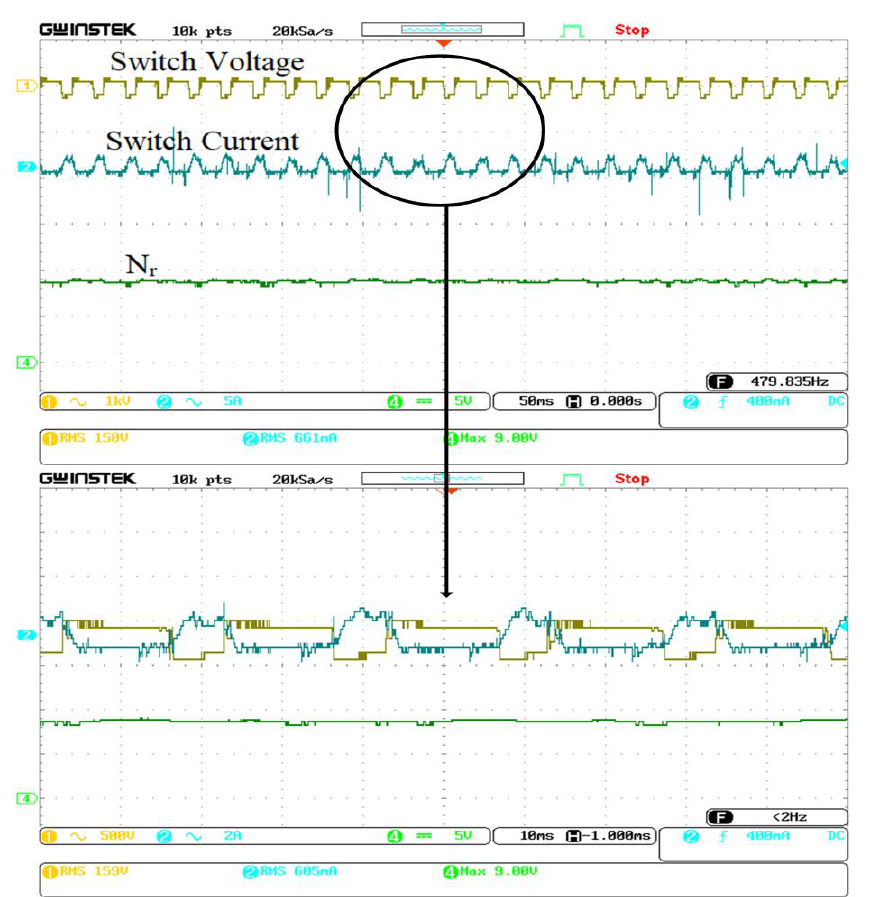
Figure 21. Voltage across switch and current flowing through the switch during variable speed op- eration.